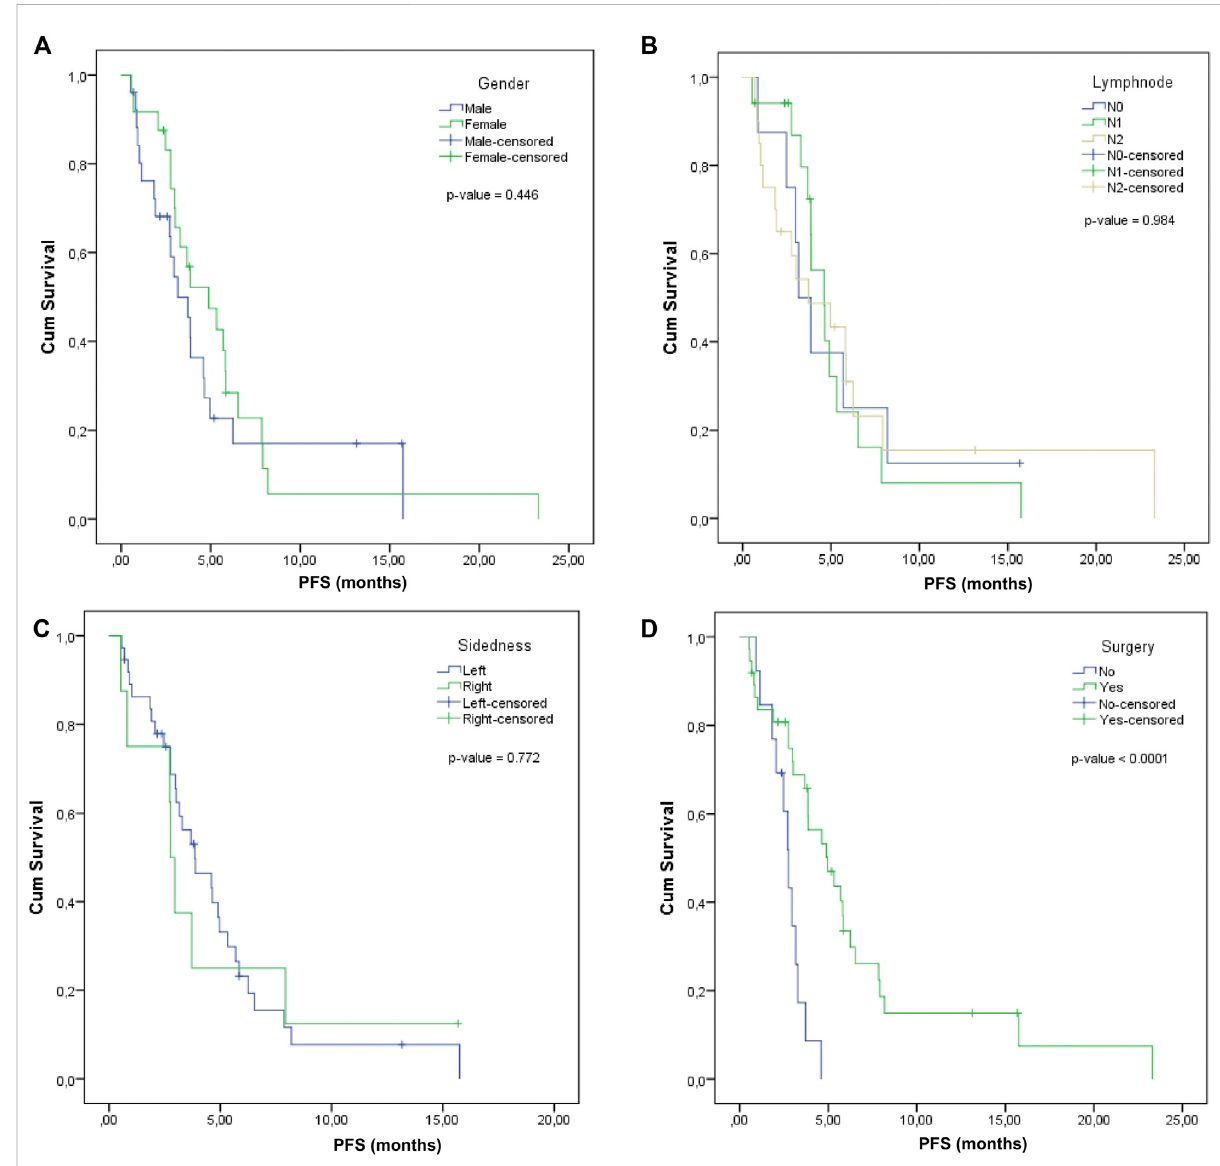
FIGURE 2 Progression-free survival according to (A) , Gender, (B) , Lymph node involvement, (C) , Tumor sidedness, (D) ,